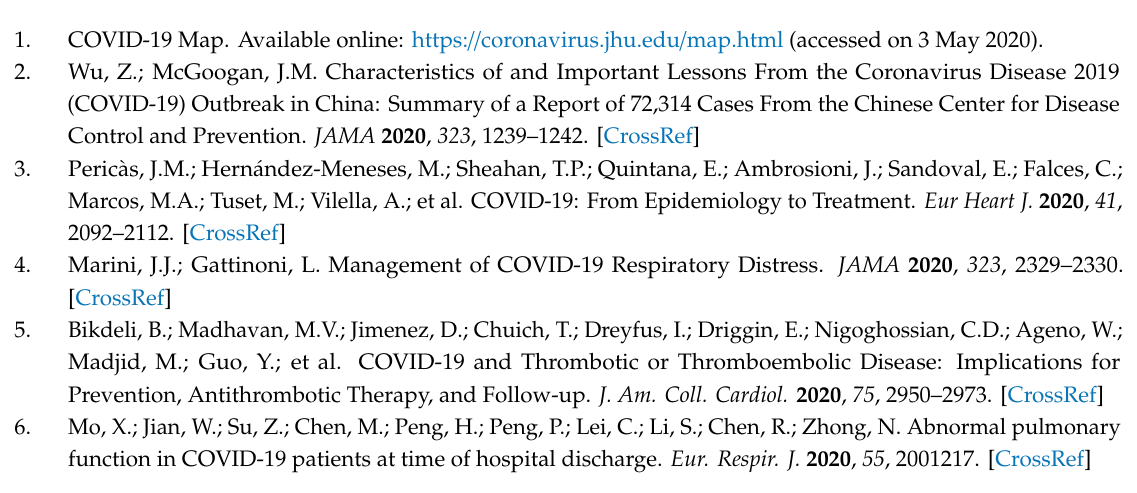
Figure S1: Patient 21 from Table S1, Figure S2: Patient 35 from Table S1, Figure S3: Patient 32 from Table S1, Figure S4: Patient 35 from Table S1; Table S1: Case-by-case description of the 58 patients included in the